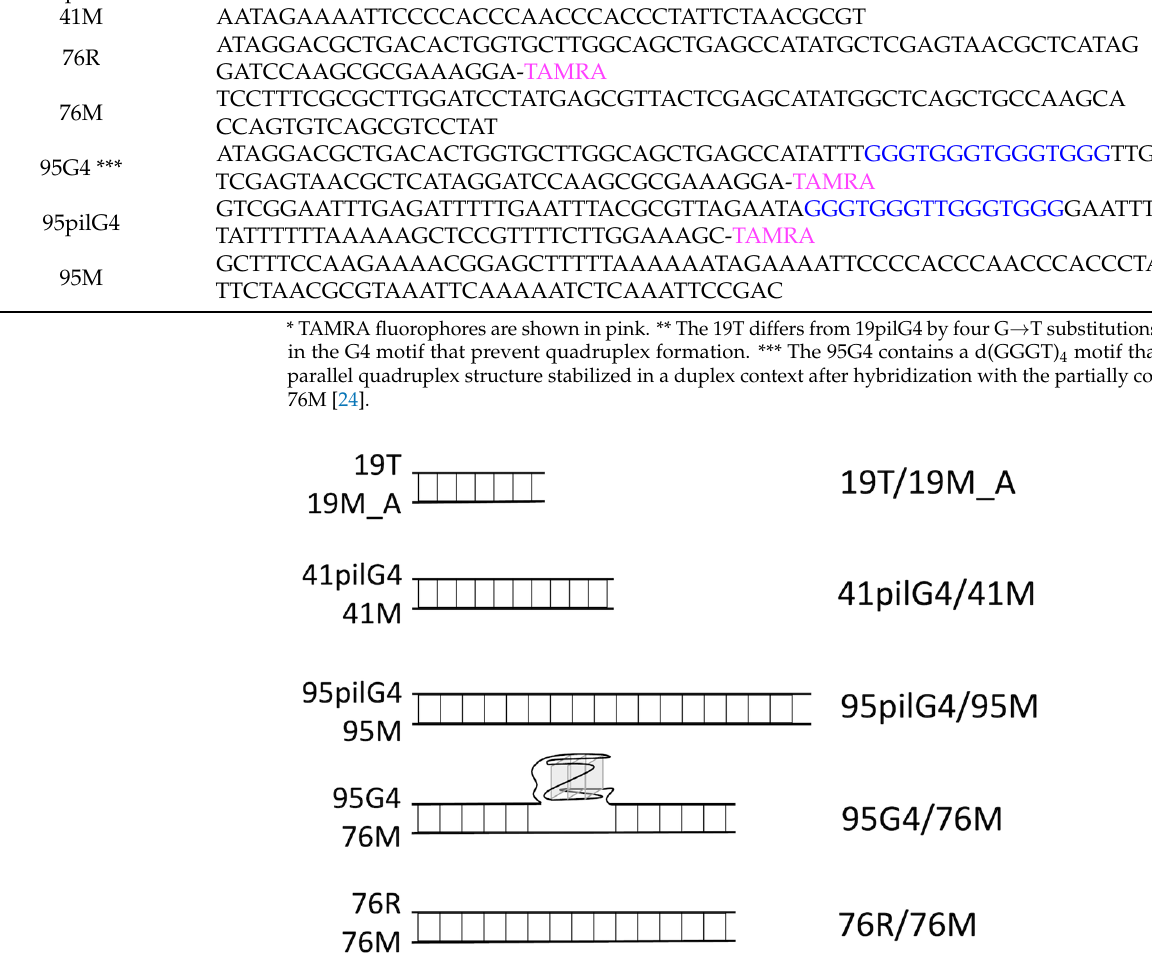
Figure 3. Schematic representations and abbreviations of DNA duplexes (right) formed by hybridization of oligonucleotides (left). The oligonucleotide sequences are shown in Table 1.